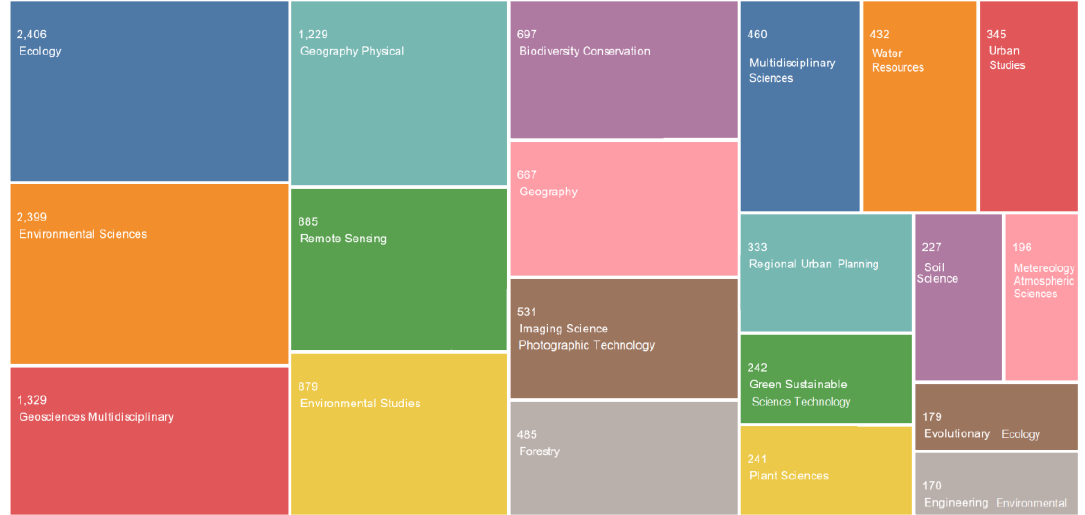
Figure 2. Tree map of the first twenty Web of Science categories where the works about spatial analysis for landscape archaeology are published.